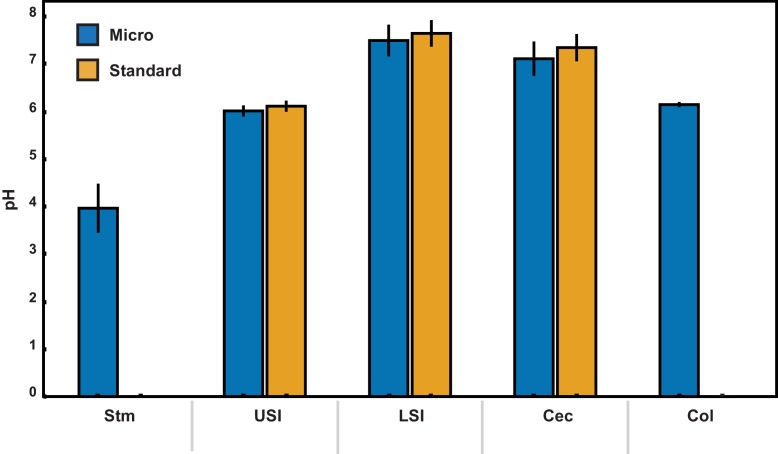
pH measurements of luminal fluid from different sections of the gastrointestinal tract.Measurements were conducted on pooled samples of luminal fluid collected from two groups of mice. Each measurement was repeated three times, and the error bars are the standard deviation across the six trials (three trials per group). Micro (blue) indicates measurements that were conducted using a micro pH electrode. Standard (orange) indicates measurements that were conducted using a standard pH electrode. For the stomach and colon samples there was insufficient luminal fluid from both groups to submerge the tip of the standard pH electrode, so measurements were only taken with the micro pH electrode. Stm = stomach, USI = upper small intestine. LSI = lower small intestine, Cec = cecum, and Col = colon.